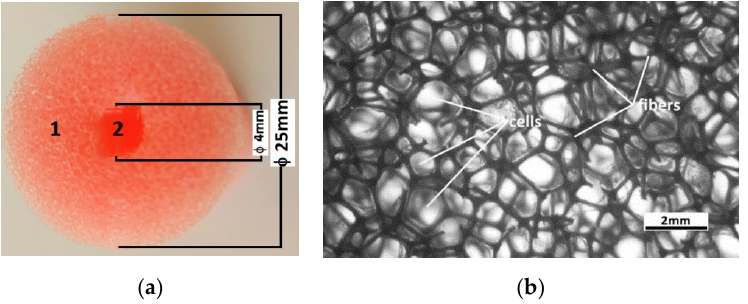
Figure 1. ( a ) Cross-section of the PS: (1) sponge body and (2) internal cylinder; ( b ) sponge body image captured with an XREC digital microscope.